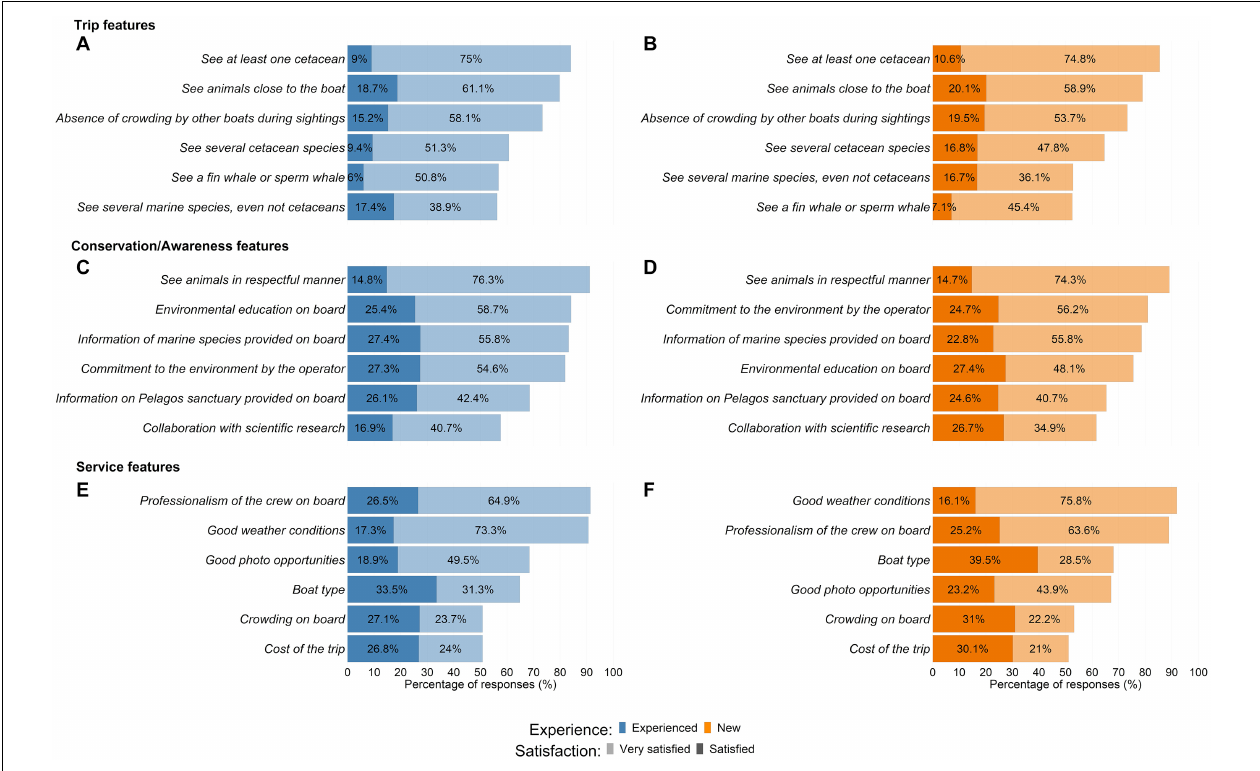
FIGURE 4 | Satisfaction for trip (A,B) , conservation/awareness (C,D) and service (E,F) features for Experienced (blue) and New (orange) whale